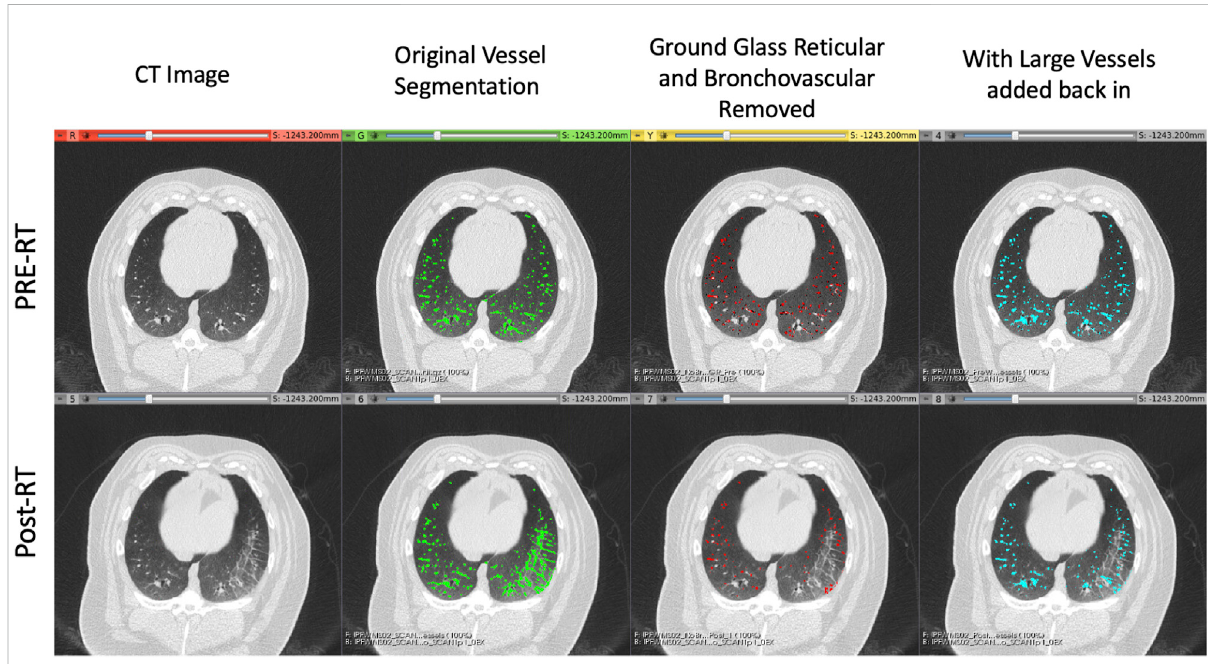
FIGURE 5 Example of the vessel segmentation algorithm results for a pre-RT (top row) and post-RT (bottom row) example. From left to right: the original CT,thevesselsegmentationdenotingvoxelsclassi fi edasvesselsingreen,theresultofremovingvoxelsthatwereclassi fi edasbothvesselsandeither ground glass reticular or bronchovascular (red), and fi nally the result of adding back in the large vessels (blue).